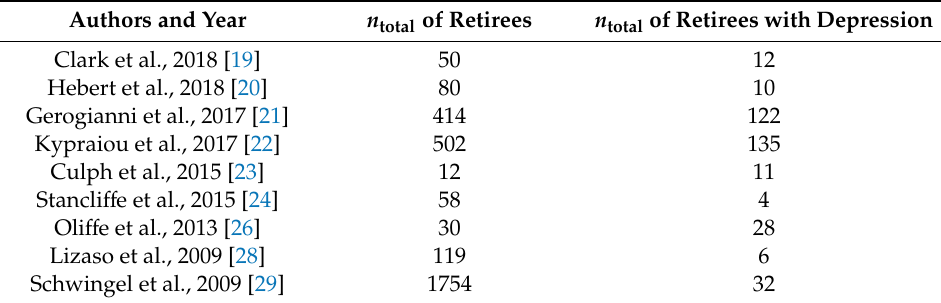
Table 3. Prevalence of depression in